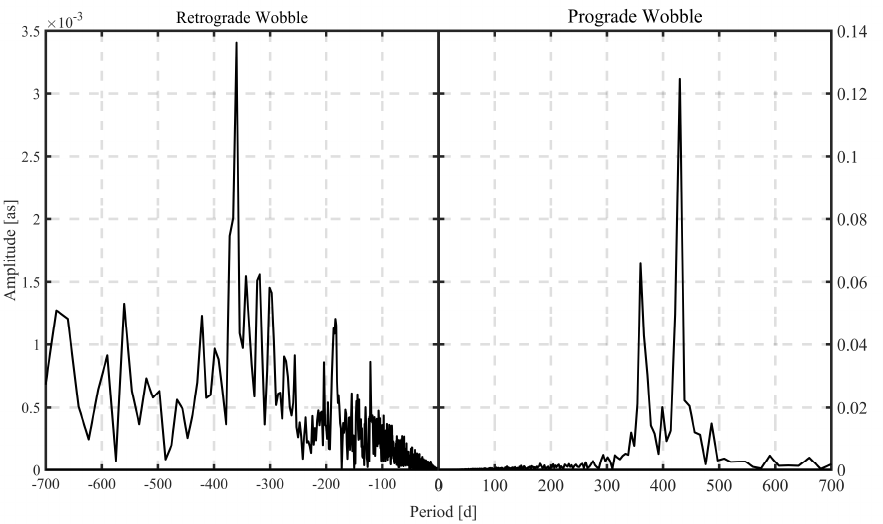
Figure 7. Spectral analysis of polar motion series: retrograde wobble ( left ) and prograde wobble ( right ); scale of amplitude of left graph is enlarged to explore retrograde wobble in more detail.